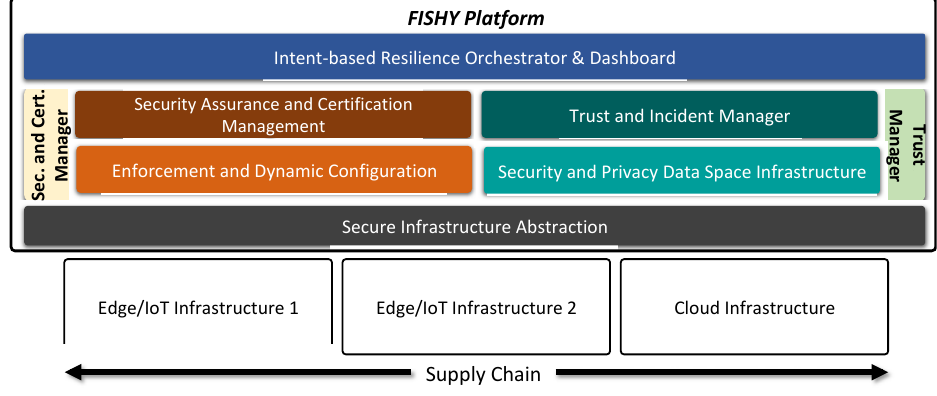
Figure 2. The technical overall concept.